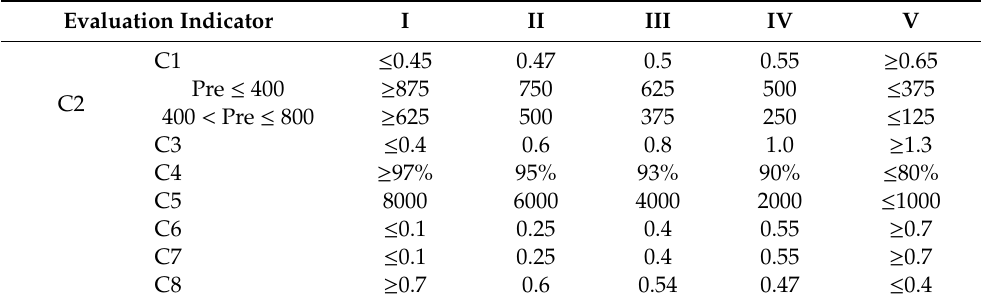
Table 2. The grade of evaluation indicator values (Pre denotes annual precipitation,